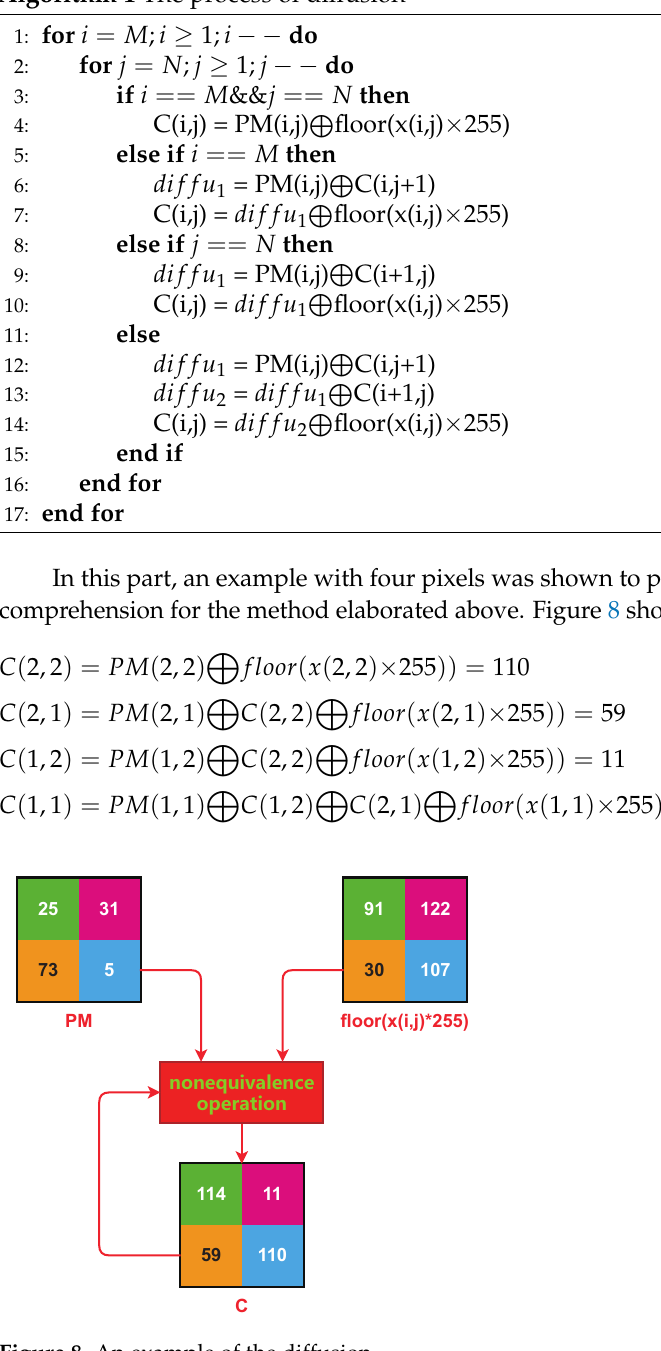
Figure 8. An example of the